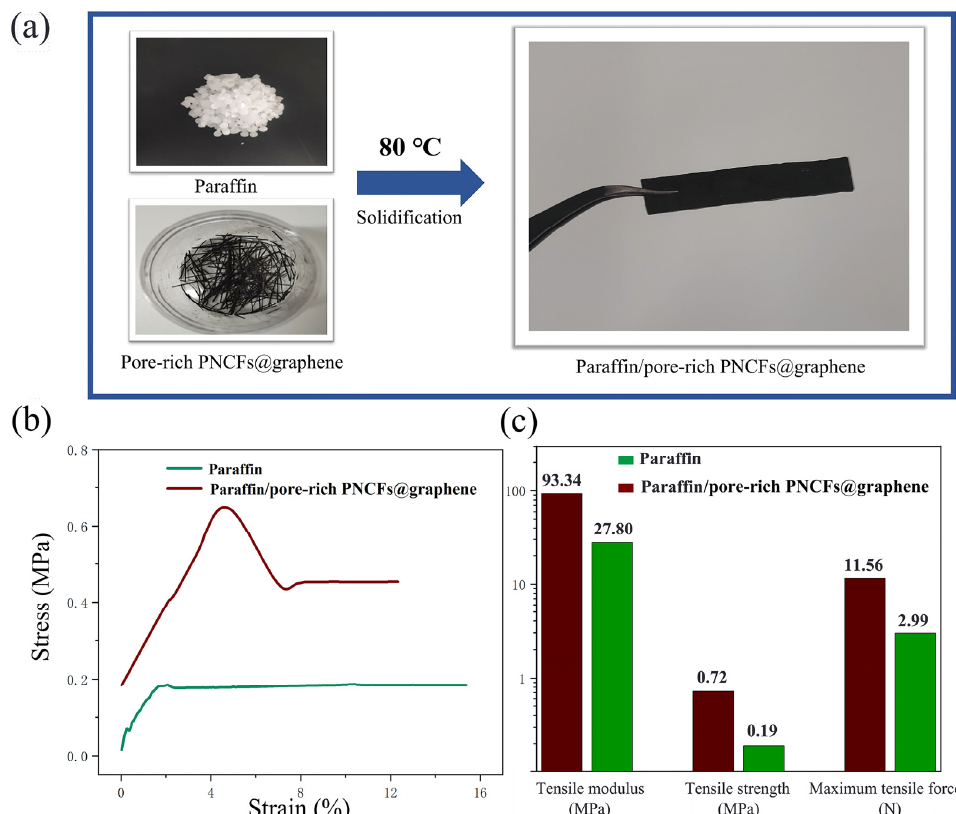
Figure 9. ( a ) Preparation of the paraffin/pore-rich PNCFs@graphene samples for tensile experiments. ( b ) Stress-strain relationships of the pure paraffin and paraffin/pore-rich PNCFs@graphene. ( c ) Tensile modulus, tensile strength, and maximum tensile force of the pure paraffin and paraffin/pore-rich PNCFs@graphene.